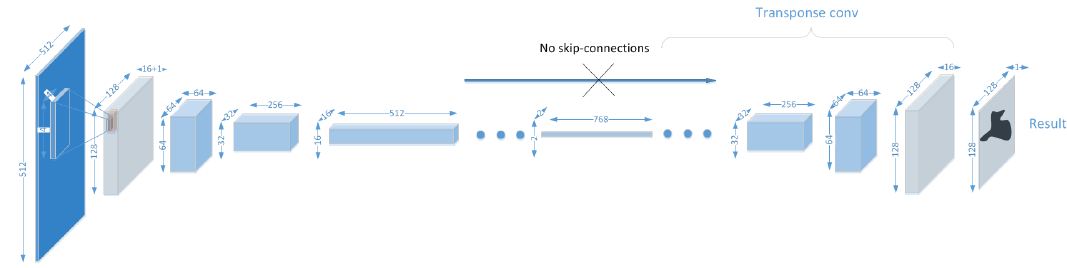
Figure 2. A common NN architecture with NiN as base